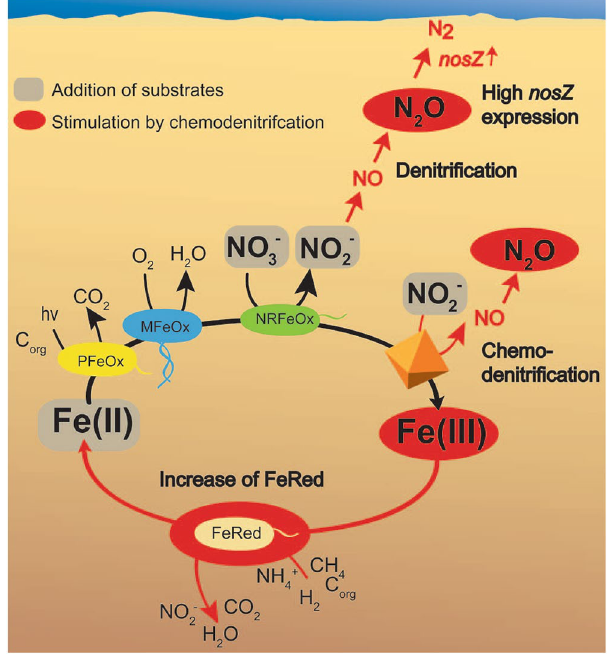
Figure 4. Cause and effects of nitrite- and nitrate-induced (chemo)denitrification-based N 2 O formation in coastal marine sediment. When Fe(II) and nitrite/nitrate was added to the marine sediment, Fe(III) was formed among different process by chemodenitrification which is stimulating Fe(III)-reducing bacteria (FeRed). The FeRed bacteria then produce Fe(II) and stimulate Fe(II)-oxidizing bacteria. Therefore chemodenitrification has a significant impact on Fe-cycling in general. Simultaneously, nitrite/nitrate was reduced to NO and further to N 2 O by chemodenitrification and denitrifying bacteria. In addition, the presence of high nitrite/nitrate concentration leads to a high typical nosZ gene expression in denitrifying bacteria which is responsible for the reduction of N 2 O into N 2